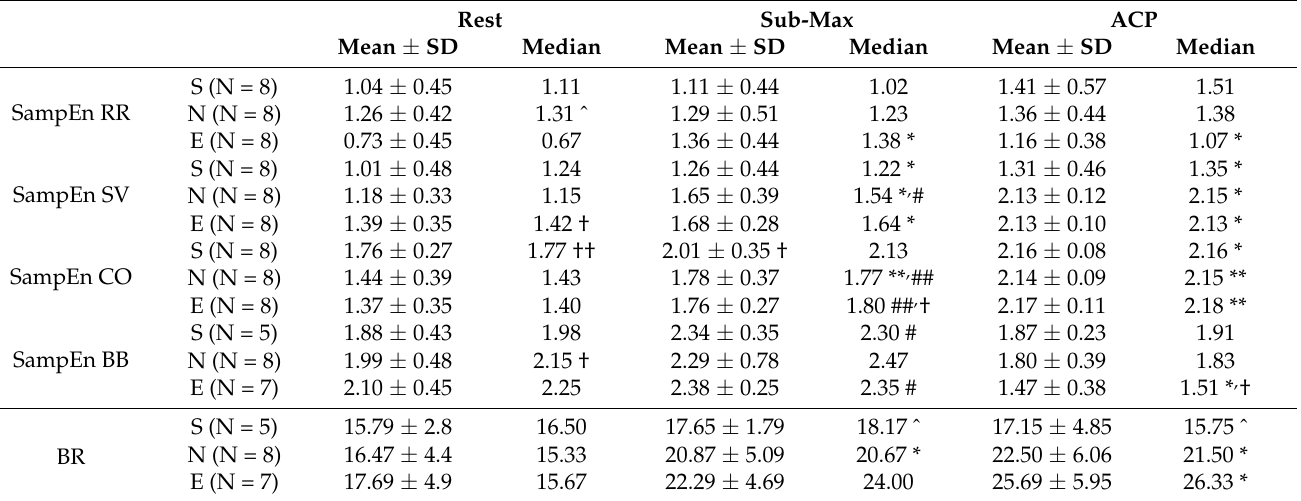
Table 5. SampEn RR, SampEn SV, SampEn CO, SampEn BB, and BR in the three groups during rest, sub-max, and ACP